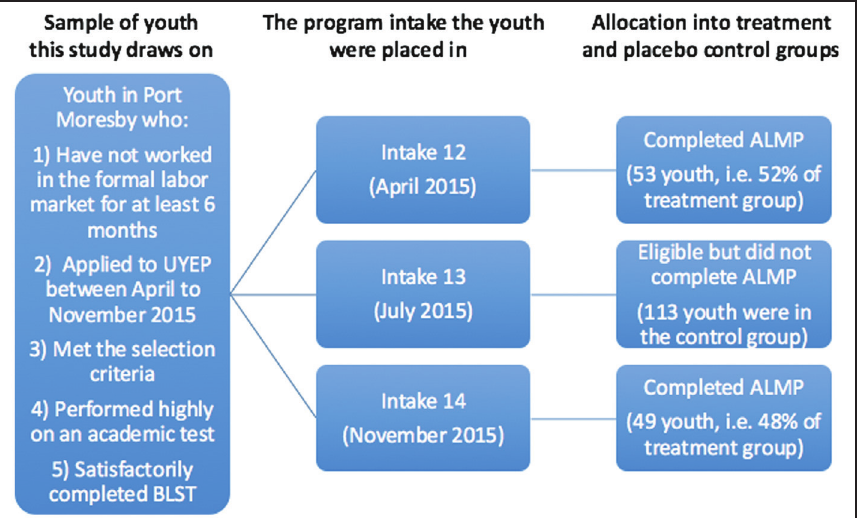
Process of selecting treatment and “placebo” control